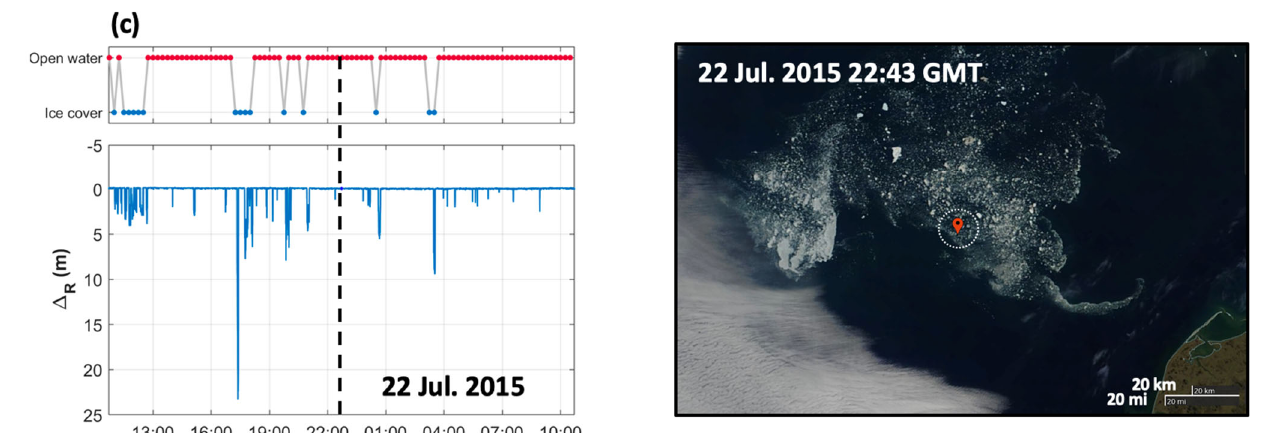
Figure 12. Examples of ∆ R (m) with corresponding SOM BMUs and accompanying mostly cloud-free true color Terra/MODIS satellite images. Three days from 2015 are plotted for the CEO site in the NE Chukchi Sea: 15 March 2015 ( a ), 27 May 2015 ( b ), and 22 July 2015 ( c ), with ∆ R time series and SOM BMU for each day (left panels; red = open water, blue = ice cover), and satellite images taken in the same day (right panels). The red marker’s point in the satellite images shows the location of the CEO moorings. The dashed vertical line in the left panels shows the approximate time of day that the satellite images were acquired, and the dashed circles in the right panels show the approximate distance ice would drift from the mooring site in a 24-h period while moving at a speed of 0.10 m s − 1 .